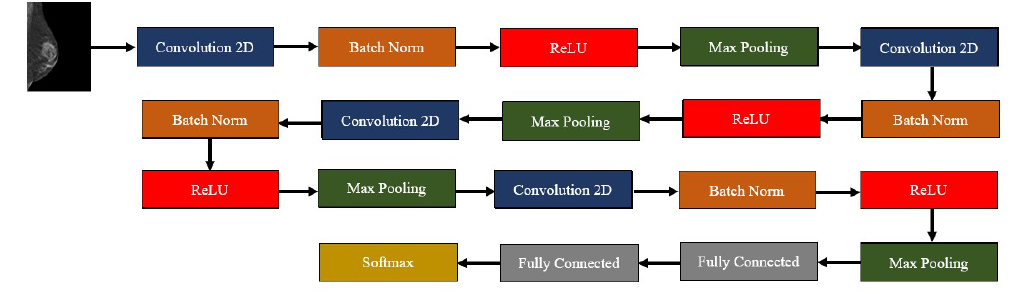
Figure 2. Outline of the developed deep learning algorithm—composed by four convolution–batch normalization–ReLU–max pooling blocks, followed by two fully connected layers and a softmax